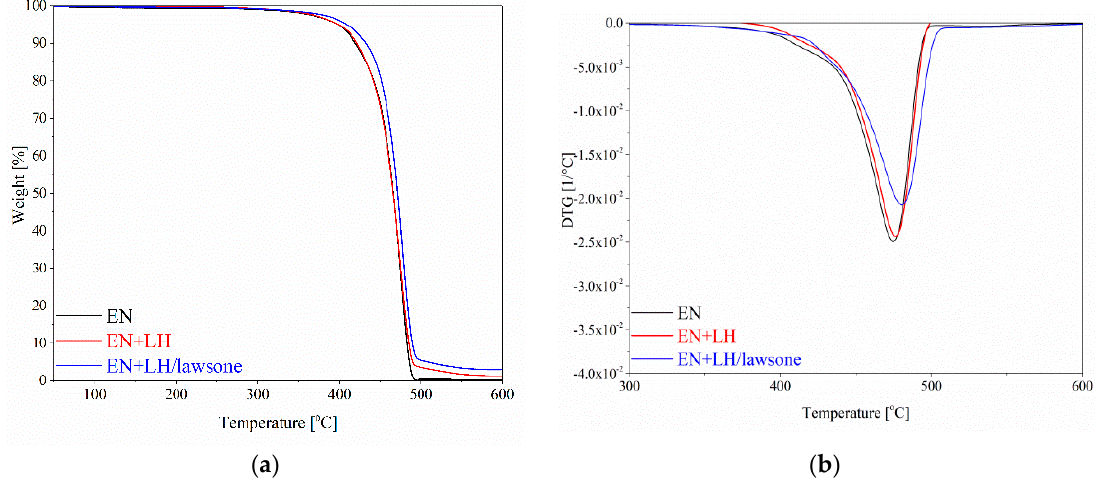
Figure 11. The TGA ( a ) and DTG ( b ) curves for EN, EN+LH and EN+LH/lawsone composites.